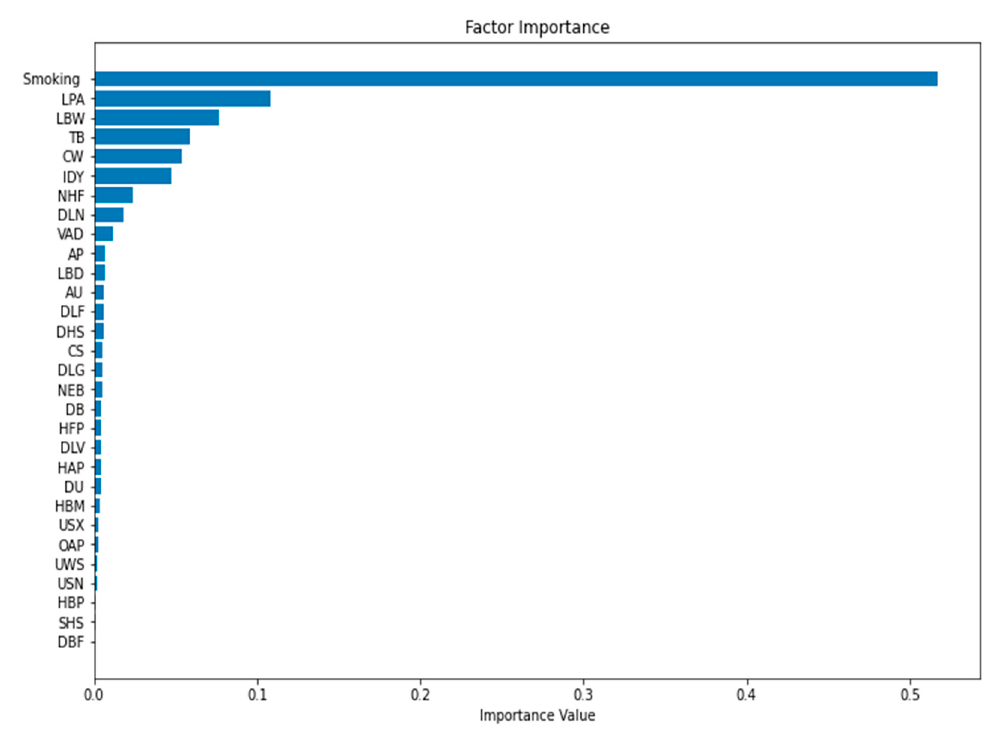
Figure 5. Importance of different risk factors determined by the FRM.